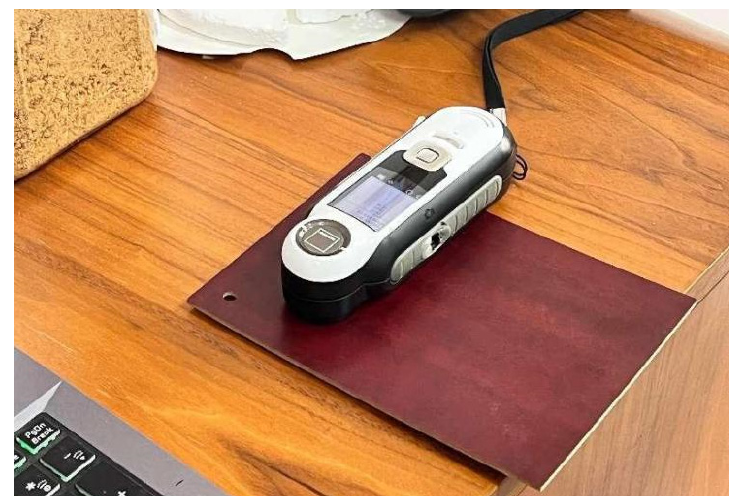
Figure 5. Material surface colour value measurement